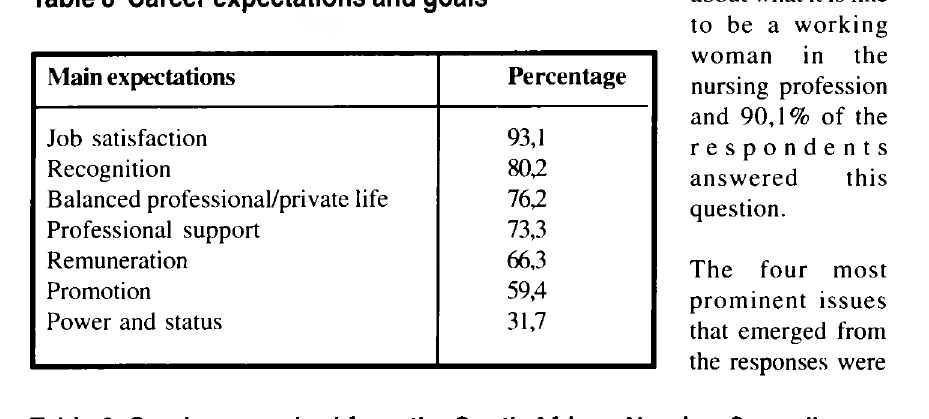
Table 8 Career expectations and goals